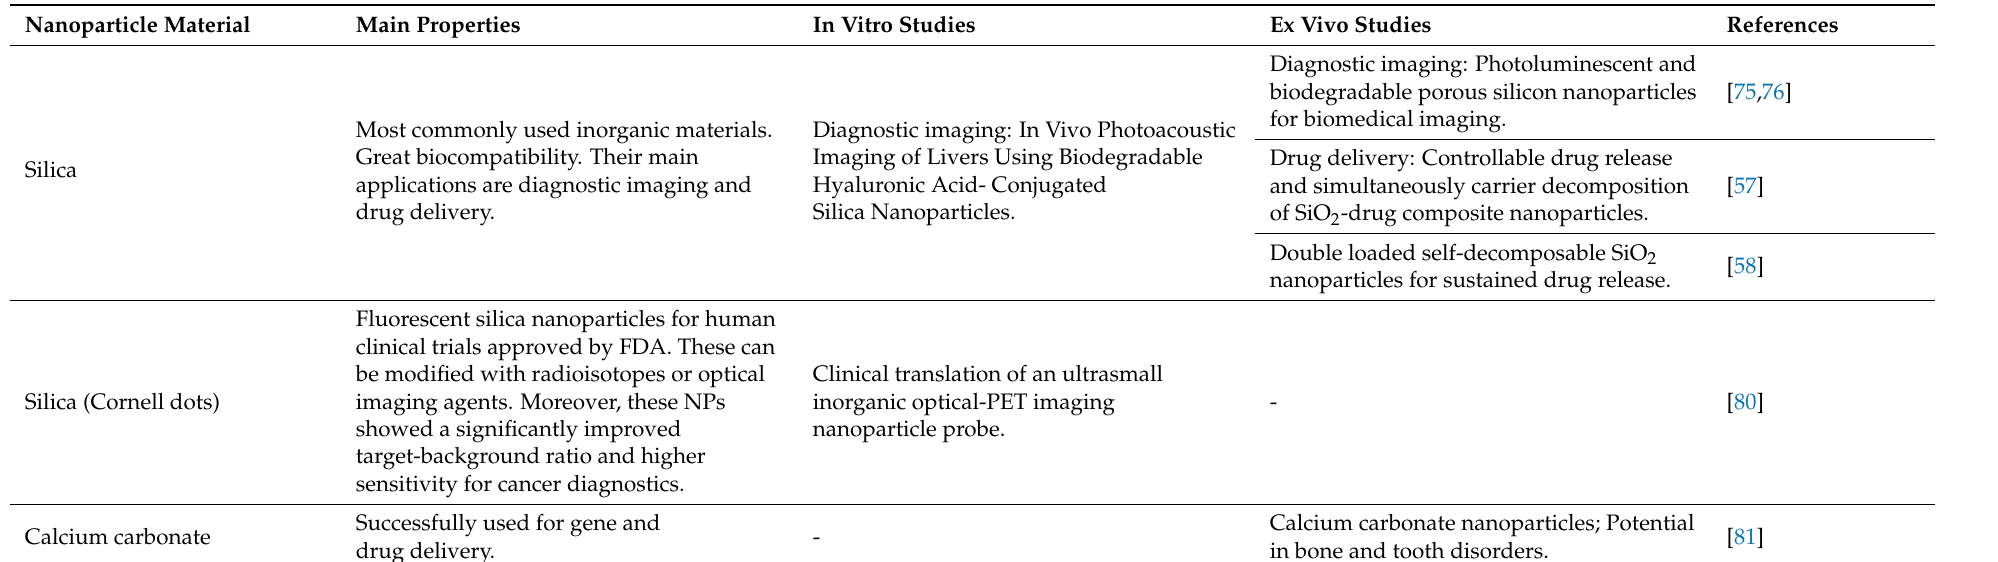
Table 1. Summary of recent advances and types of inorganic NPs in the medical